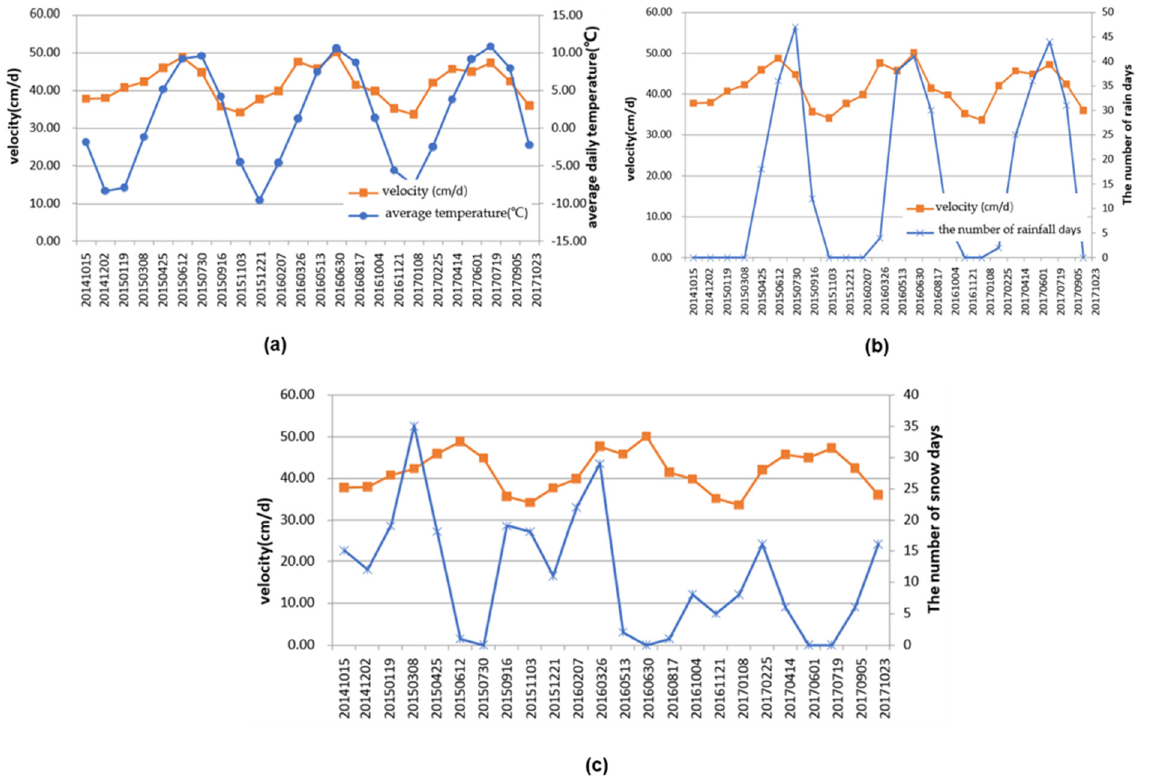
Figure 16. Average of surface velocity of the Yiga Glacier and the variation of ( a ) the average daily temperature, ( b ) the number of rainfall days, and ( c ) the number of snowfall days in the region over each period of the image pairs.